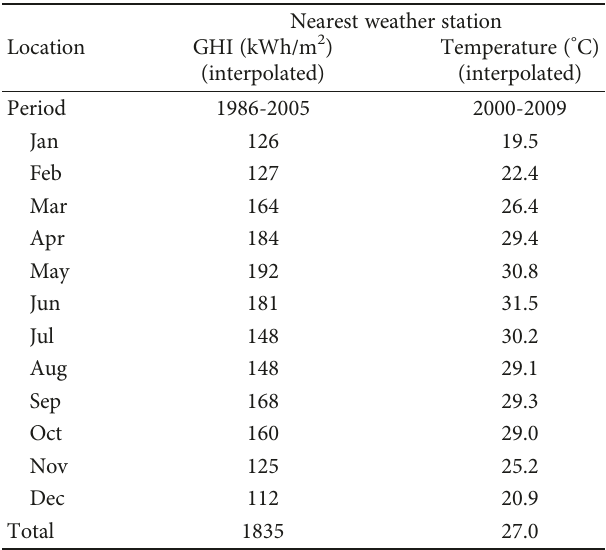
Table 6: Monthly values of GHI and temperature from the Meteonorm from the nearest weather station.